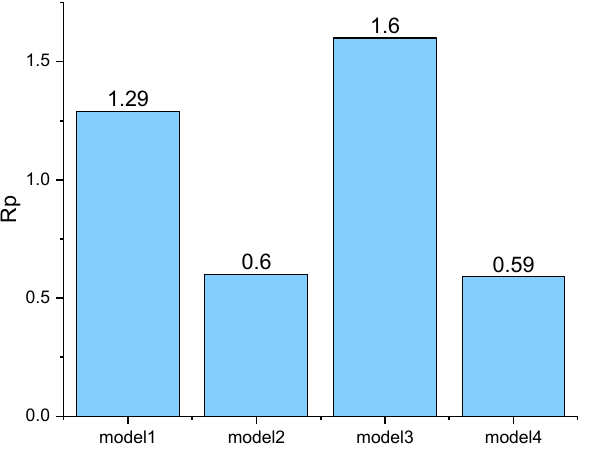
Figure 8. Comparison of 𝑅 (cid:3043) of the injected fuel in the domain at the inlet velocity of 300 m/s.